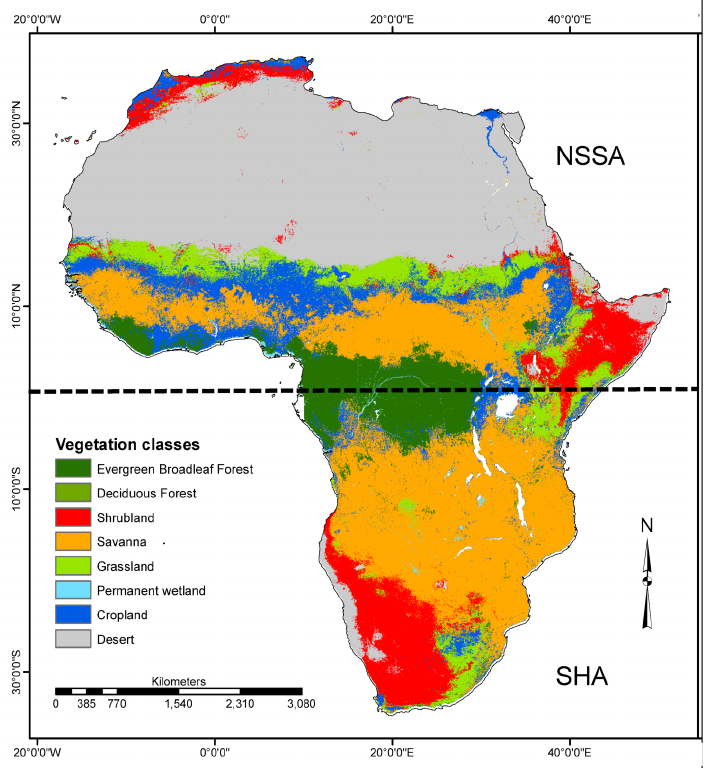
Figure 1. Map of the vegetation classes in Africa following International Geosphere–Biosphere Programme (IGBP) land cover classification. NSSA is northern sub-Saharan Africa, while SHA is southern-hemisphere Africa. The two regions, separated by the equator (represented by a back dotted line), together constitute sub-Saharan Africa (SSA). This map was adopted from